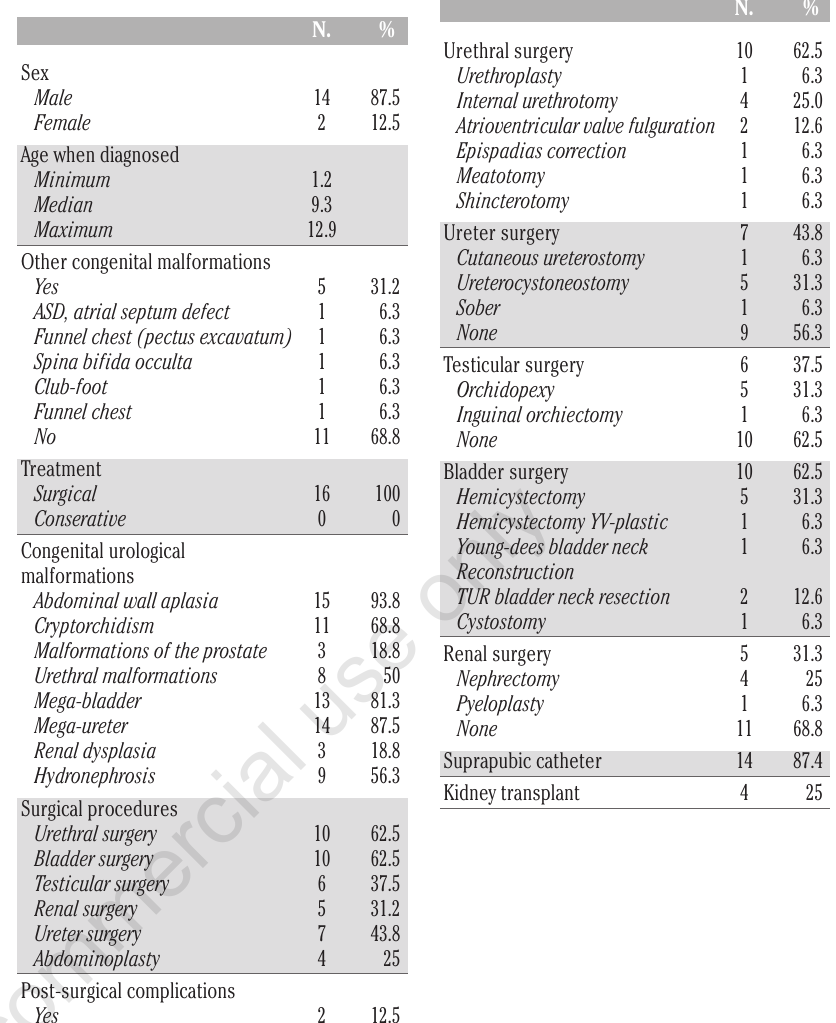
Table 1. The clinicopathological character-